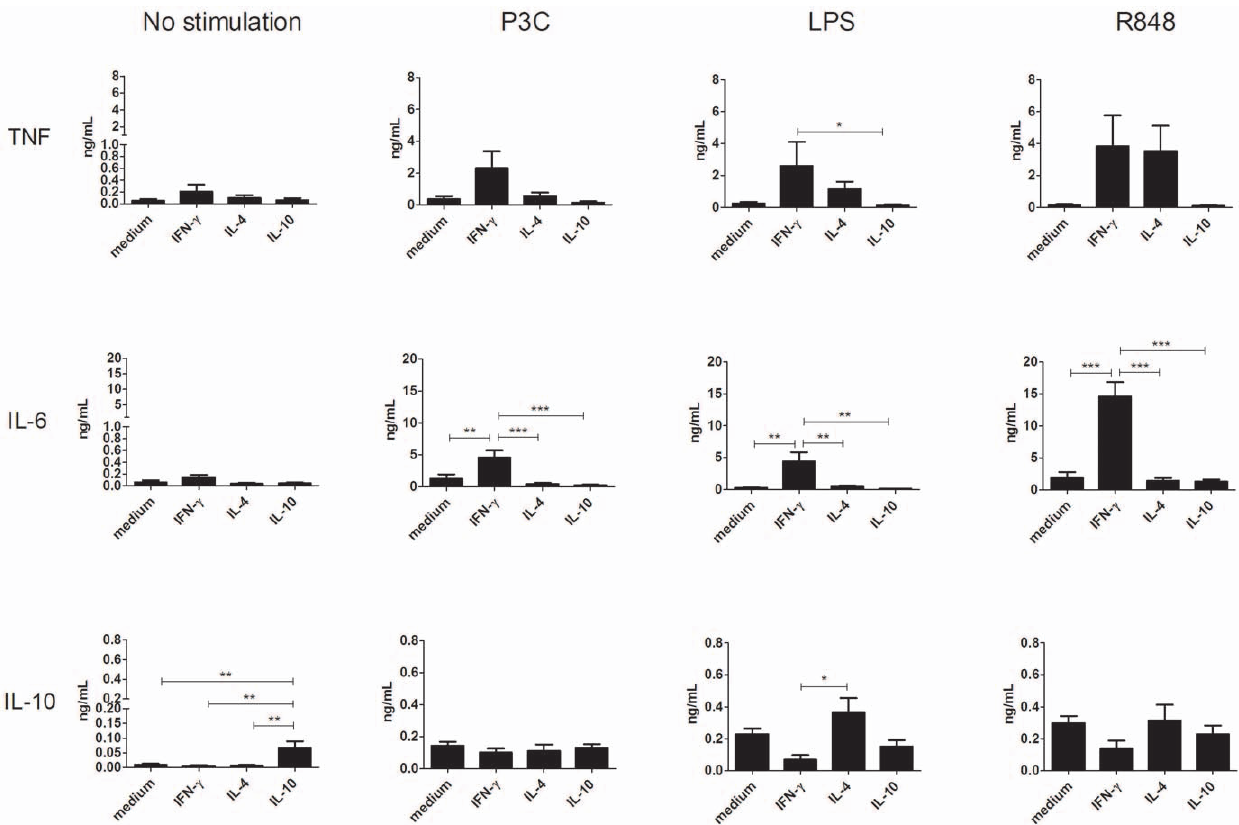
Figure 2. TLR-induced production of TNF, IL-6, and IL-10 by M W IFN- c , M W IL-4 , and M W IL-10 . Healthy peripheral blood monocytes were cultured for 4 days in medium or in medium supplemented with IFN- c , IL-4, or IL-10. Polarized macrophages were not stimulated, or stimulated for 20 hours with P3C, LPS, or R848. Bars represent the mean 6 SEM of 6 independent experiments. *p , 0.05, **p , 0.01, ***p , 0.001.